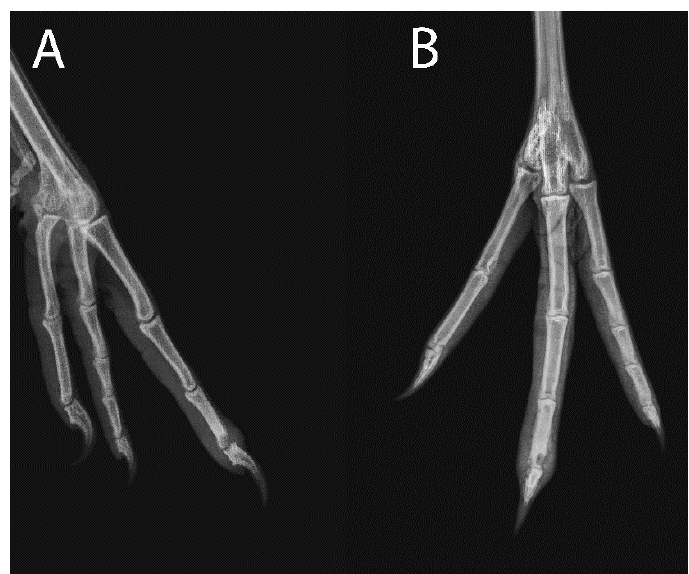
Figure 2. ( A) Lateral and ( B ) dorsoplantar radiographs of the right foot of Case 2, a 31-year-old male Siberian crane ( Leucogeranus leucogeranus ) with probable osteomyelitis of the third digit of the right foot at time of